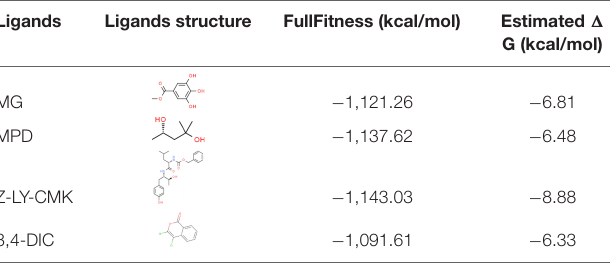
TABLE 2 | Results of ClpP docking with certain ligands.